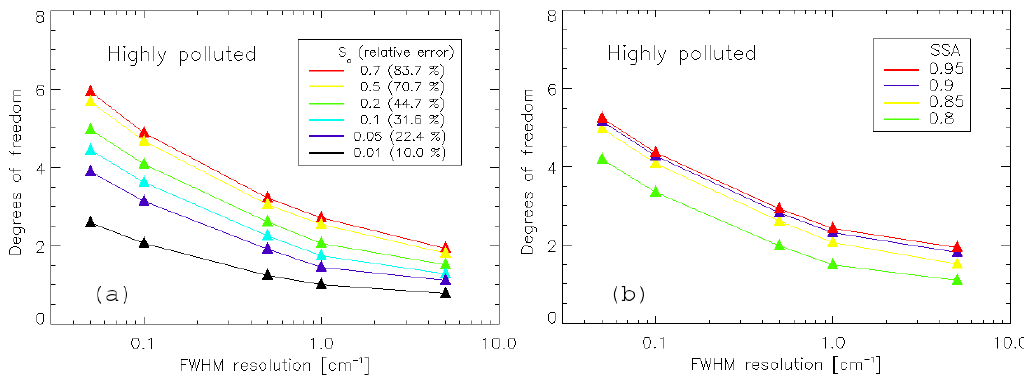
Figure 5. Highly polluted scenario total degrees of freedom for different aerosol extinction profile uncertainties S a (a) . Degrees of freedom four values of single scattering albedo ω = [0.8, 0.85, 0.9, 0.95], to simulate different type of aerosol, are shown in (b) . SZA = 45 ◦ and a nadir instrument viewing have been used.